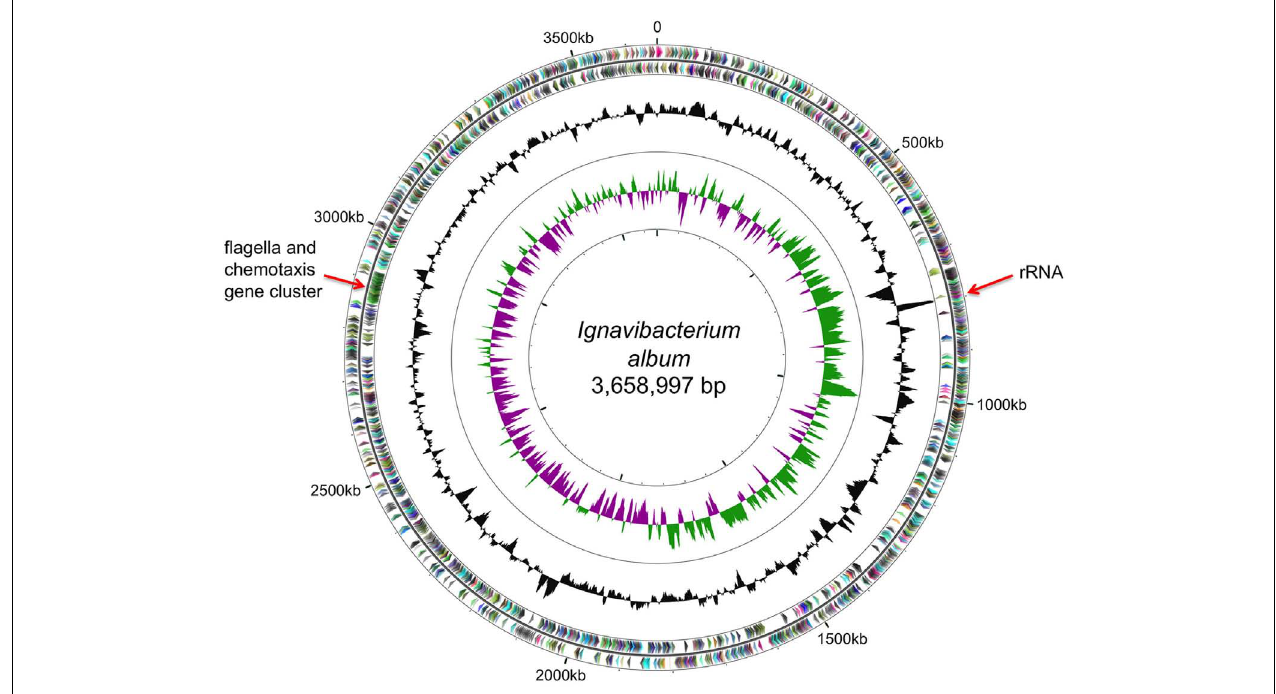
FIGURE 2 | Circular map of I. album genome. Circles from outside in: genes on the forward strand; genes on the reverse strand; G + C% plot; and